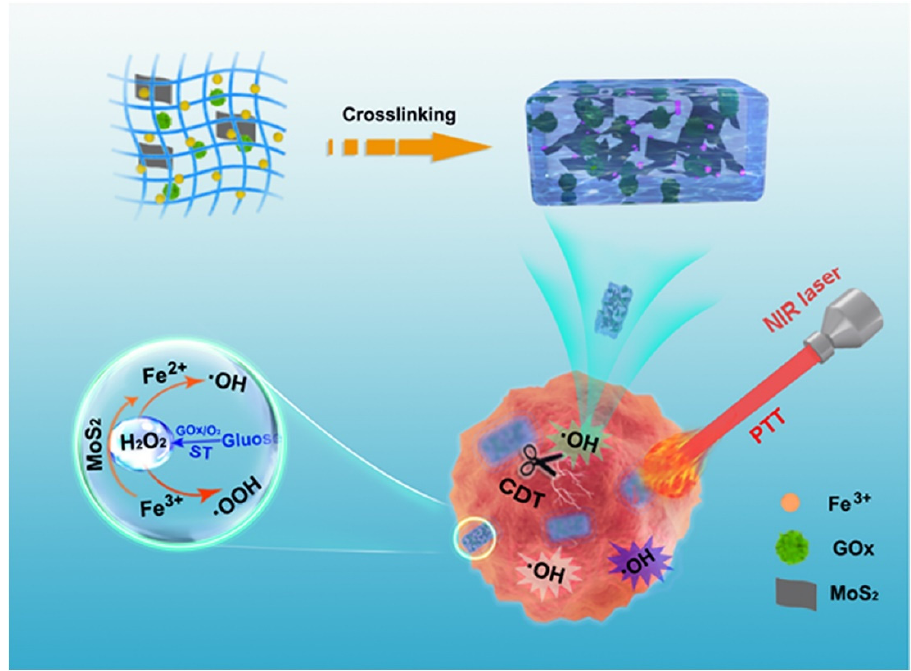
Figure 14. Schematic illustration of the sodium-alginate hydrogel system for combinational photothermal/starvation/chemodynamic therapy. Reprinted with permission from [273].